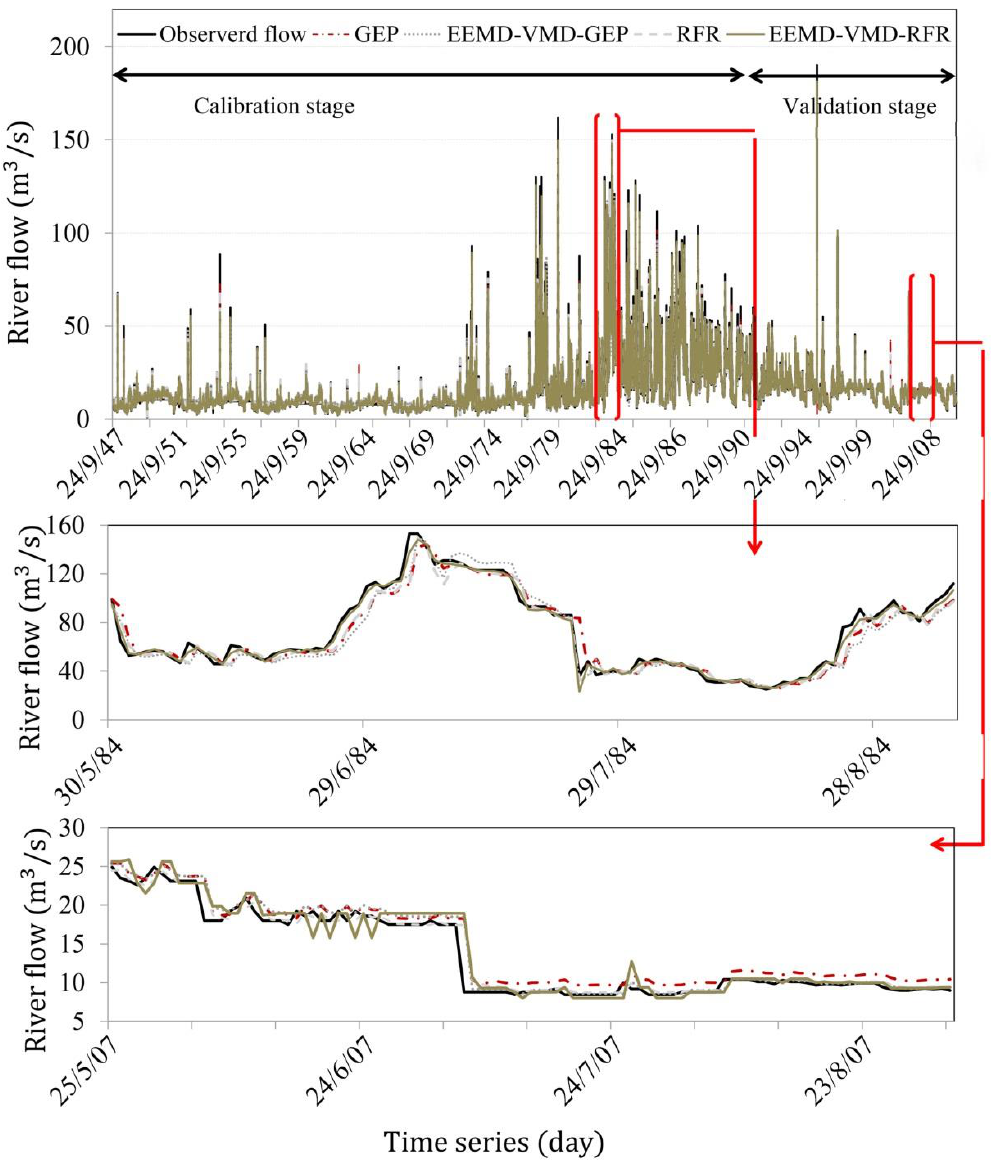
Figure 10. A time-series of observed and forecasted river daily streamflow of ensemble EEMD-VMD-GEP and EEMD-VMD-RFR models compared with standalone GEP and RFR